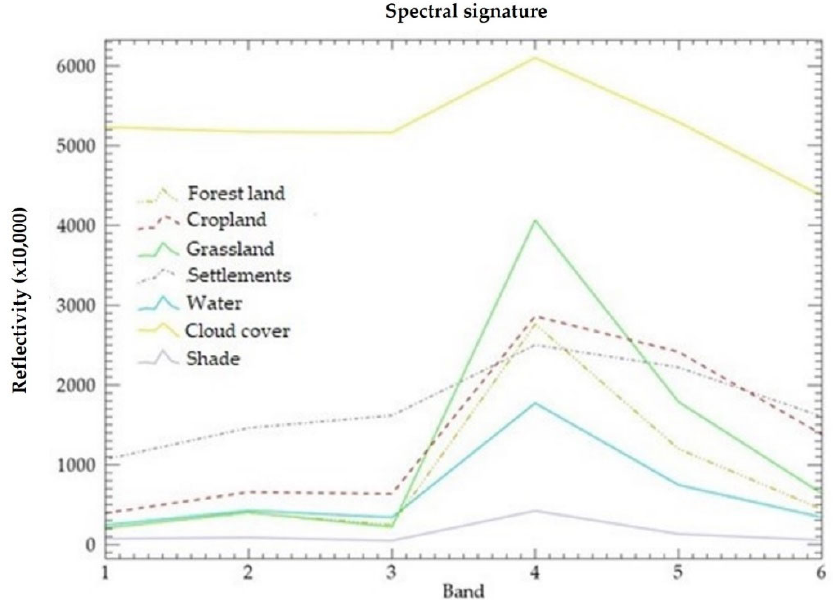
Figure 3. Typical spectral signature resampled from Landsat 8 (2018) imageries for the Life and Diversity Zone, Yasuní Biosphere Reserve of the Ecuadorian Amazon Region.